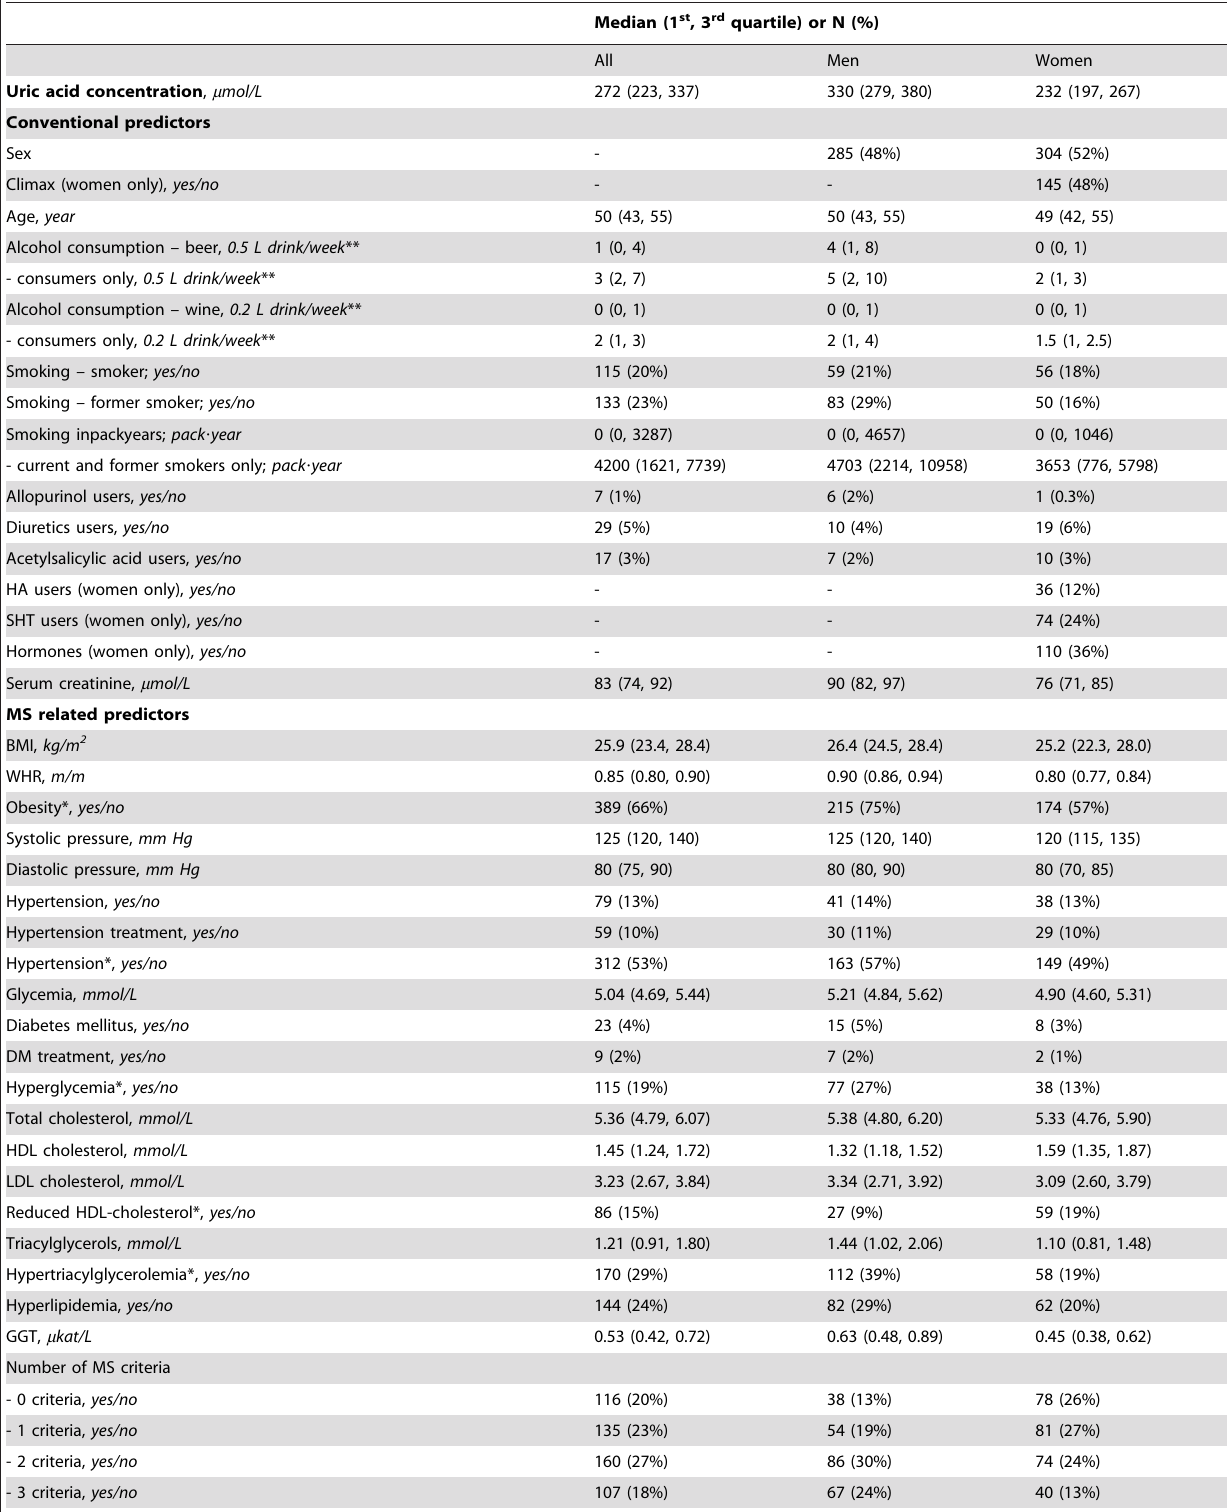
Table 1. Overview of the UA concentrations and conventional and MS related variables in the study